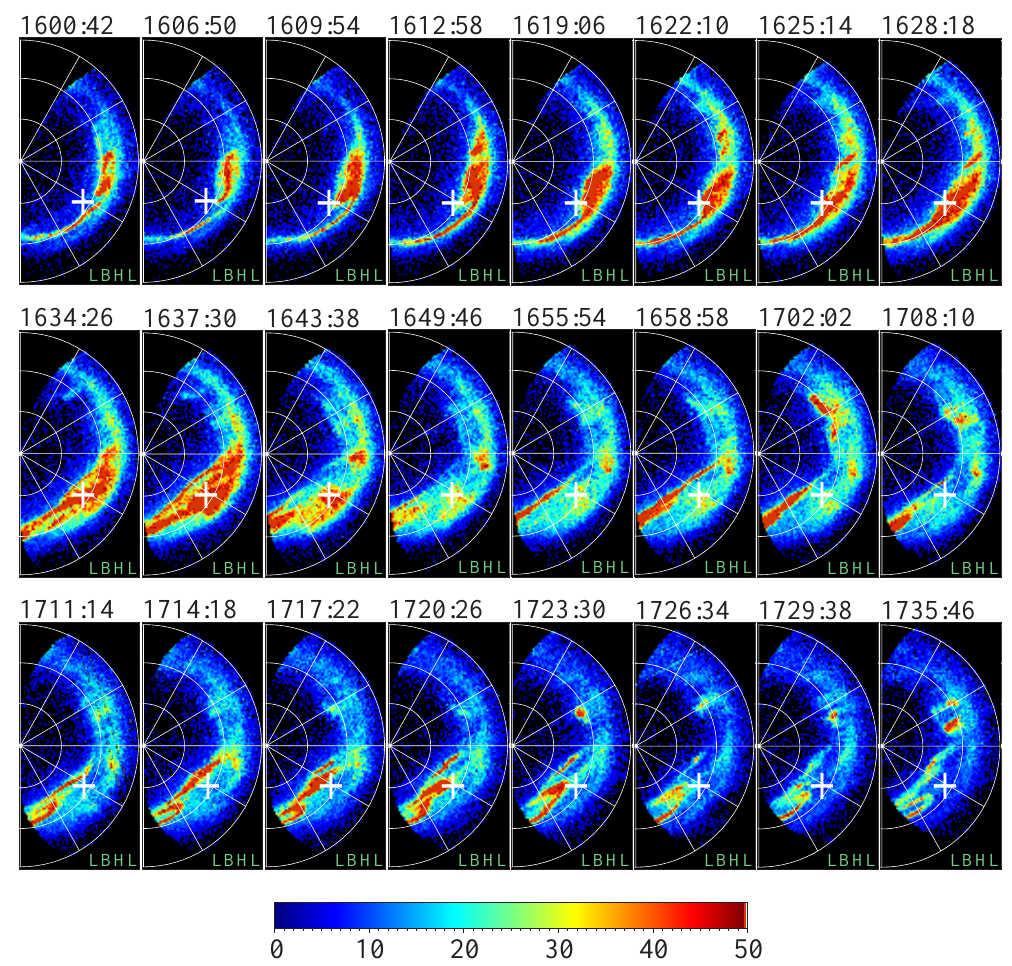
Fig. 4. A sequence of Polar UVI images recorded on 16 December 1998 between 16:00:42 and 17:35:46UT. Only every third image is displayed. The projection of the Interball-1 satellite at ionospheric altitude as computed from T89 is indicated by a white cross in each